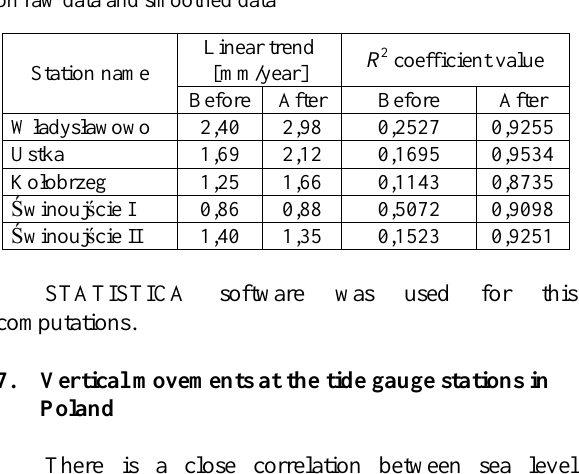
Table 1. Results obtained from linear regression computations on raw data and smoothed